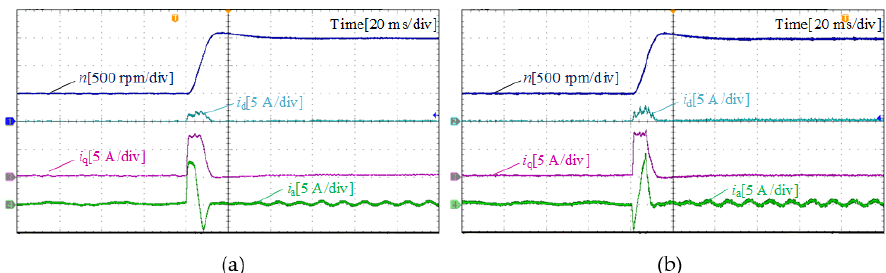
Figure 9. Dynamic experimental waveforms when the reference speed changes from 500 rpm to